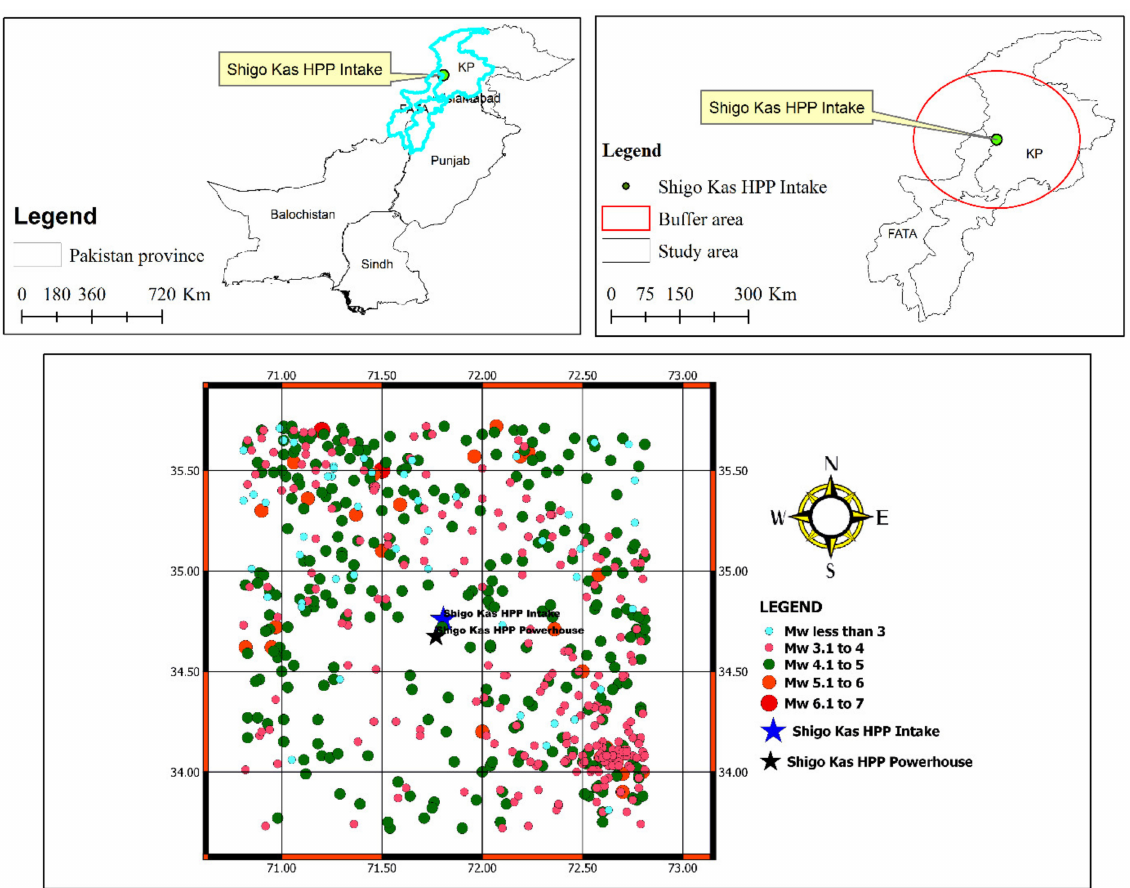
Figure 3. Distribution of the epicenters of earthquakes around Shigo Kas